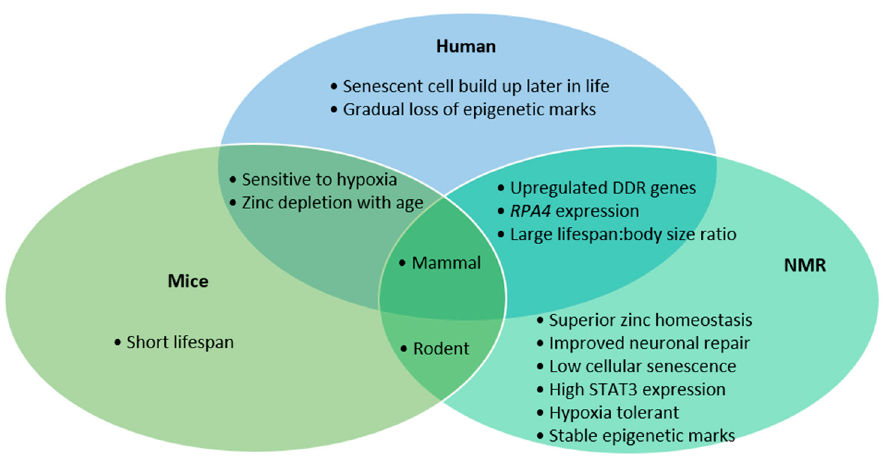
Figure 1. Summary of features relevant to neurodegeneration among mice, humans and naked mole rats. While mice and human cells are sensitive to hypoxia and lose zinc homeostasis with age, human and NMR cells share upregulated DNA damage response (DDR), including highly expressed mismatch repair, non-homologous end-joining, homology-directed repair and base excision repair pathways. Moreover, both NMRs and humans share a high lifespan to body ratio and express a unique subunit of the RPA complex—RPA4.